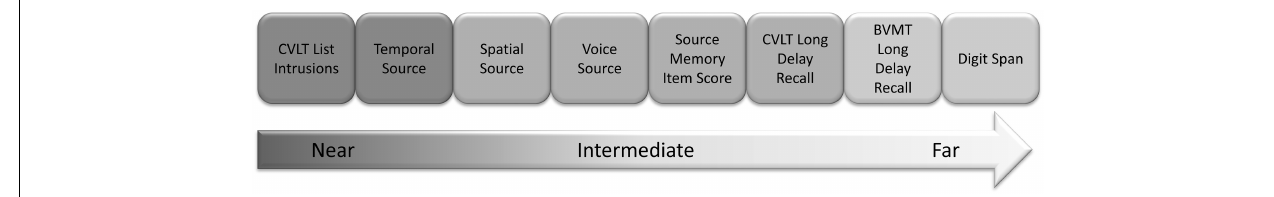
FIGURE 1 | Near-, intermediate- and far-transfer